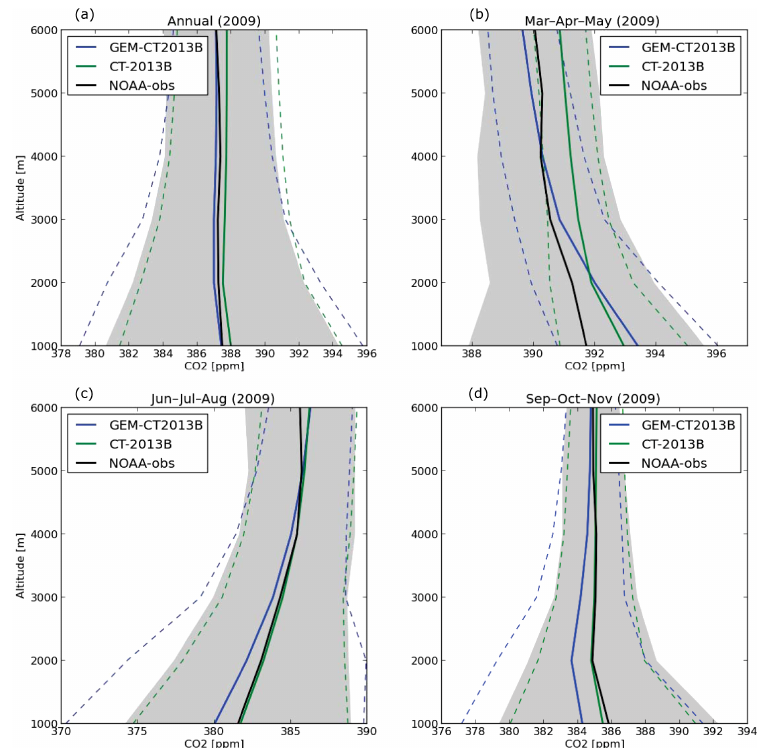
Figure 8. Comparison of model mean profiles to NOAA aircraft observations. Observations (black curves) are from obspack_co2_1_PROTOTYPE_v1.0.4_2013-11-25 for locations over continental USA and Canada, only. Observed and modelled profiles are binned over (a) 2009, (b) March to May 2009, (c) June to August 2009 and (d) September to November 2009. CarbonTracker 2013B mole fractions (green) and GEM-MACH-GHG with CT2013B posterior fluxes (blue curves) are shown in all panels. The shaded grey re- gions indicate plus or minus 1 standard deviation for the observations while the dashed coloured lines indicate the same quantities but for the different model runs. Note that the x axis range differs in each panel and that ticks are every 5ppm except for (b) where they are every 2ppm. Sites used are Beaver Crossing, Nebraska; Bradgate, Iowa; Briggsdale, Colorado; Cape May, New Jersey; Charleston, South Carolina; Dahlen, North Dakota; East Trout Lake, Saskatchewan; Estevan Point, British Columbia; Fairchild, Wisconsin; Harvard Forest, Massachusetts; Homer, Illinois; Oglesby, Illinois; Park Falls, Wisconsin; Poker Flat, Alaska; Sinton, Texas; Southern Great Plains, Oklahoma; Trinidad Head, California; West Branch, Iowa; Worcester,